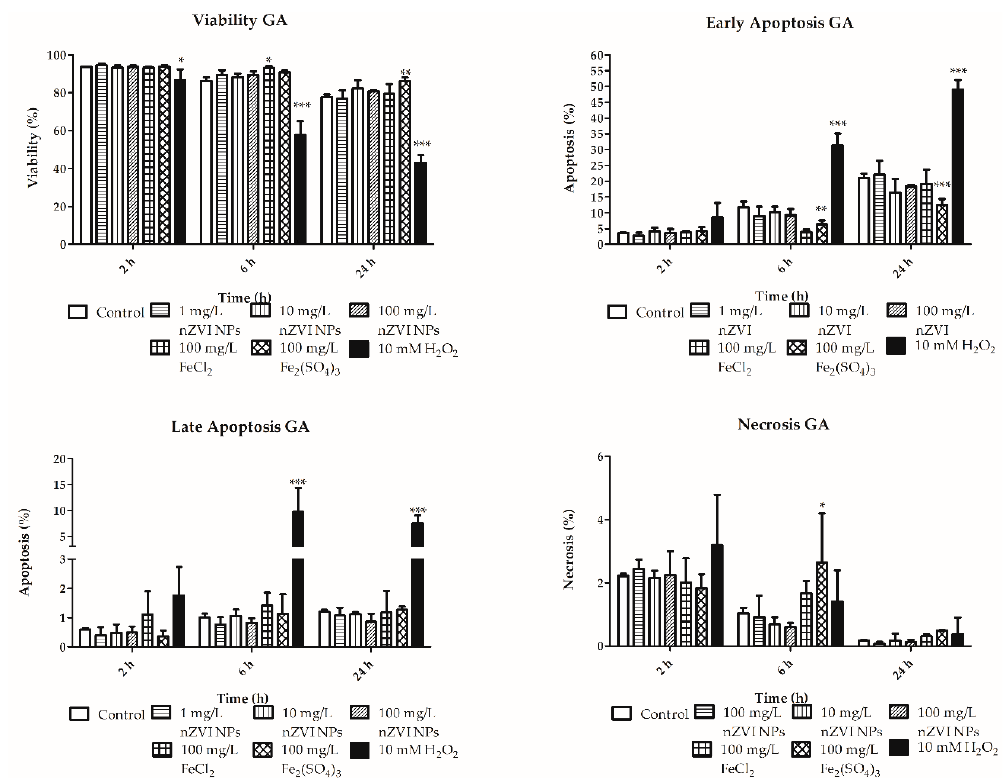
Figure 4. Viability, early and late apoptosis, and necrosis of granular amoebocytes (GA) after exposure to nZVI NPs, FeCl 2 and Fe 2 (SO 4 ) 3 for 2, 6 and 24 h; 10 mM H 2 O 2 was used as a positive control; * p <